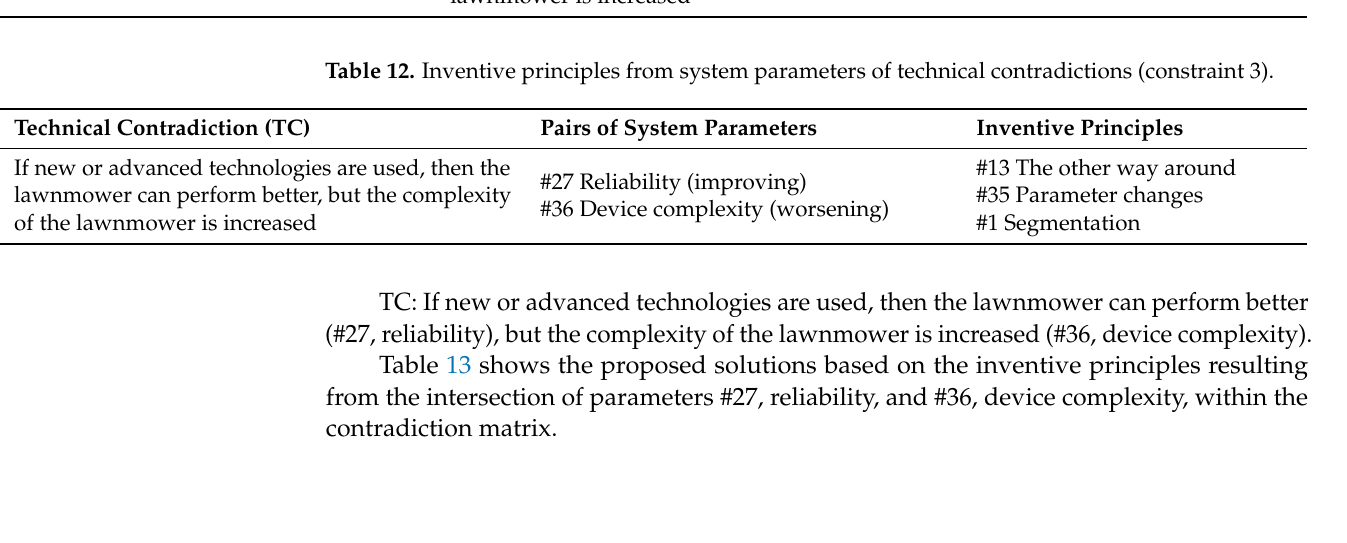
Table 11. System parameters for technical contradiction (constraint 3).